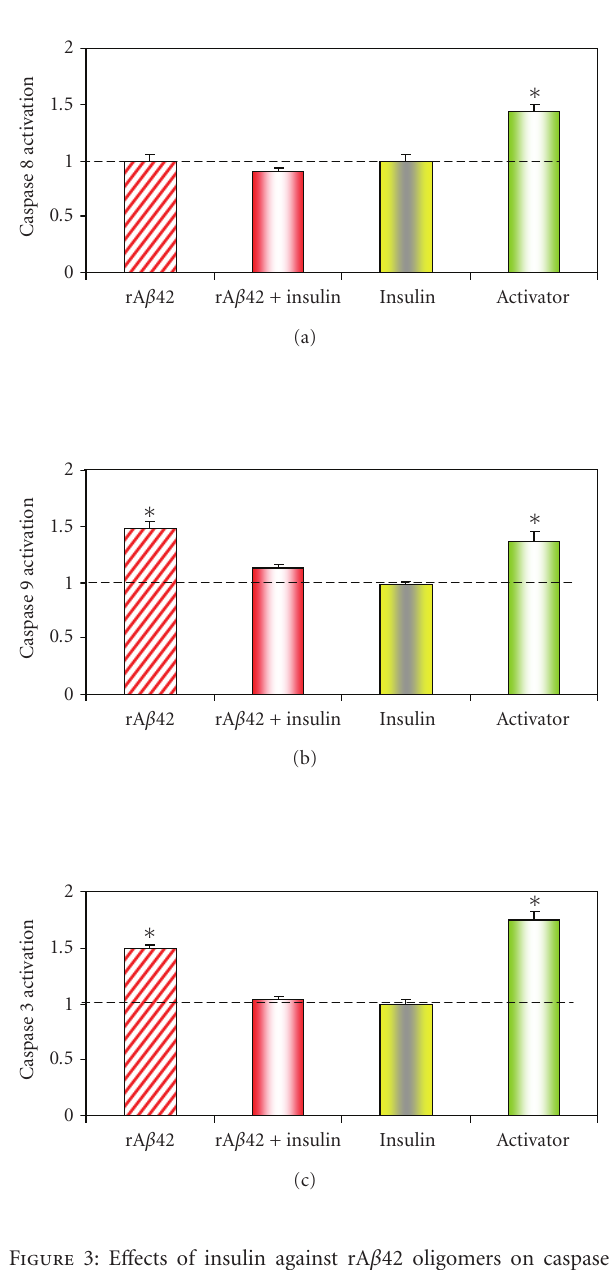
Figure 3: E ff ects of insulin against rA β 42 oligomers on caspase 9 and 3 activation. LAN5 were untreated (control), treated with rA β 42 oligomers (40 μ M) for 1 h (rA β 42), rA β 42 oligomers (40 μ M) for 1 h and insulin (100 μ M) for 4 h (rA β 42 + insulin), insulin alone (100 μ M) for 4 h (insulin), 50 μ M Vinblastine for 4 h (activator) and submitted to caspase 8 (a), caspase 9 (b), and caspase 3 (c) luminescent assays. Data expressed as percentage of the corresponding control. The dashed line shown in the histogram corresponds to a control culture. The activation of caspase 8 (a) is significantly high with activator ∗ P < . 02, whereas it is not significantly high in rA β 42 versus control. The activation of caspase 9 (b) is significantly high in rA β 42 ∗ P < . 01 and in the activator ∗ P < . 05, whereas it is not significantly high in rA β 42 + insulin versus control. The activation of caspase 3 (c) is significantly high in rA β 42 ∗ P < . 01 and in the activator ∗ P < . 01, whereas it is not significantly high in rA β 42 + insulin versus control. Values are referred to control, the data are the mean ± SD of three separate experiments.